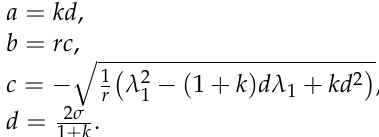
Figure 2. Solution graphs obtained for the proposed test problem (3) in nine test points shown in Figure 1. The blue line is 𝑥 (cid:2869),(cid:3041) obtained by the Euler method. The red line is a reference solution for 𝑥 (cid:2869),(cid:3041) found using the ode78 solver in MATLAB [17]. Figure 2 illustrates the various behaviors of the solutions. Solutions in points (a) and (c) are unstable, as predicted by the position of the points relative to the stability region. The solution (b) is oscillatory since point (b) is on a boundary of the stability region. All these solutions are obviously erroneous relative to the continuous prototype. Solutions obtained in points (d), (e), (g), and (h), which lie within the stability region, show dy- namics that are also rather far from the real dynamics of the prototype system. Only the solutions in cases (f) and (i) are somewhat close to the real dynamics of the continuous